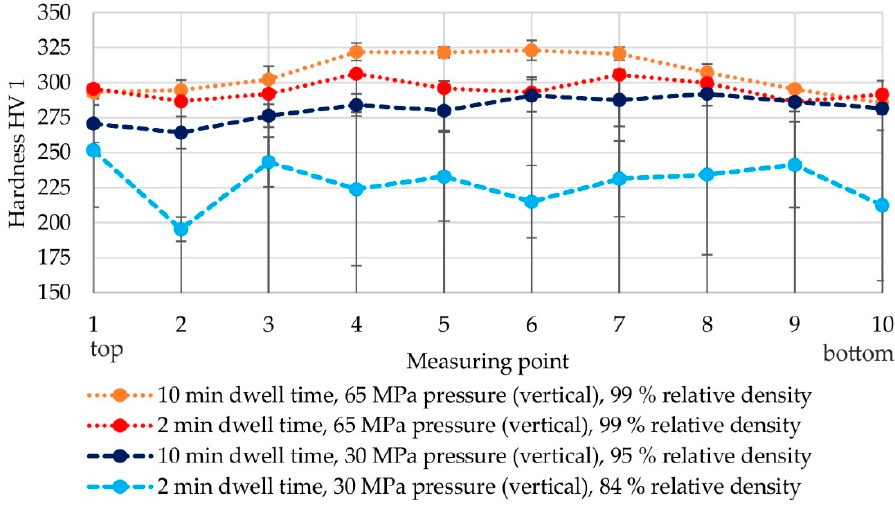
Figure 6. Hardness profiles in vertical direction from top to bottom of the samples of GE48, sintered at 1150 °C.